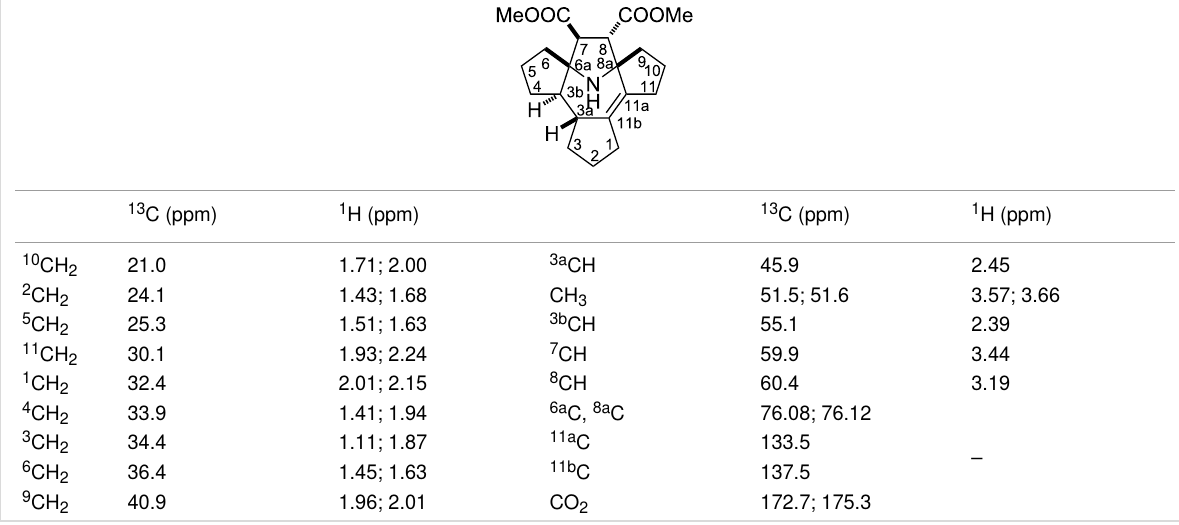
Table 1: NMR Assignment of 1 based on the HSQC, COSY 1 H, 1 H and 1 H, 13 C